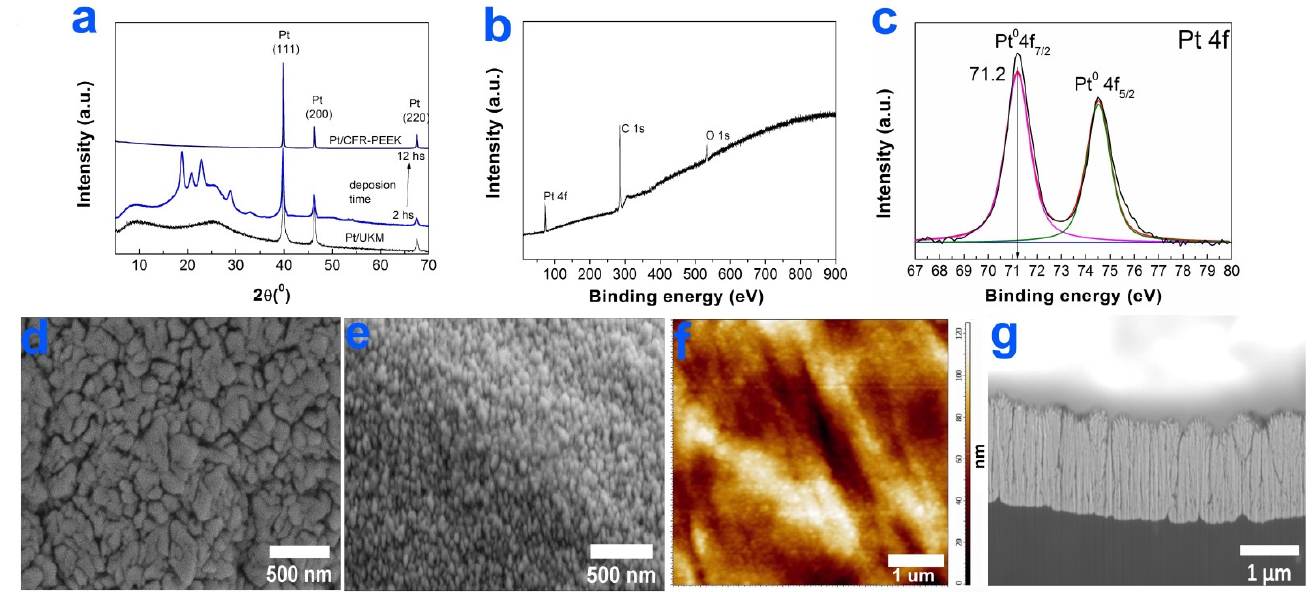
Figure 4. Characterization of Pt films: XRD patterns of Pt/CCM, Pt/CFR-PEEK-2, and Pt/CFR-PEEK-12 ( a ), XPS spectra of Pt/CFR-PEEK ( b ), fitting of Pt4f spectra ( c ), SEM micrographs of the surface of Pt/CCM ( d ) and Pt/CFR-PEEK ( e ), AFM micrograph of Pt/CFR-PEEK ( f ), and FIB-SEM cross-section micrograph of Pt/CFR-PEEK ( g ).